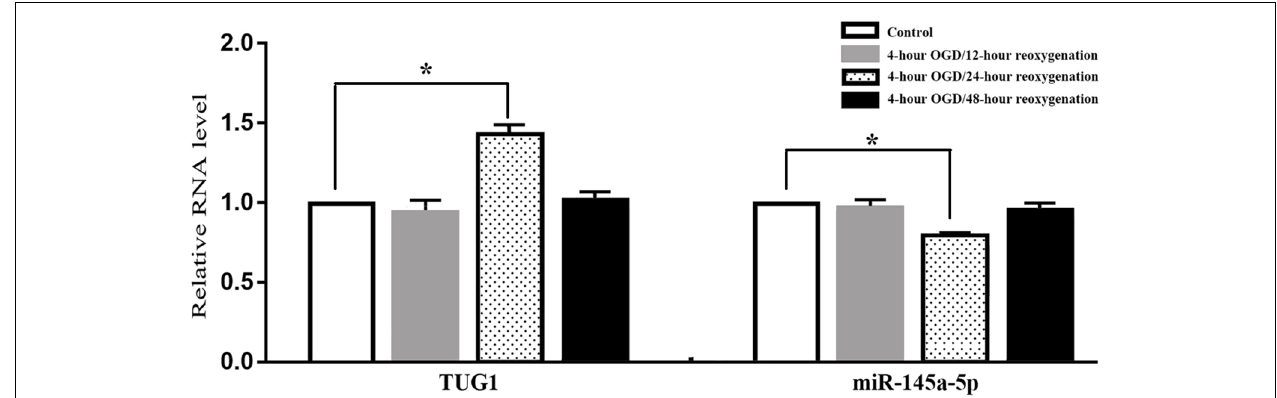
FIGURE 1 | Quantification of RNAs by quantitative real-time-polymerase chain reaction (qRT-PCR), displaying transiently up-regulated taurine up-regulated gene 1 (TUG 1) concomitant with down-regulated miR-145a-5p after 4-h OGD and 24-h reoxygenation. No significant difference was observed at 12-h or 48-h reoxygenation. ∗ P < 0.05 vs. the corresponding control. OGD, oxygen-glucose deprivation. n = 6.